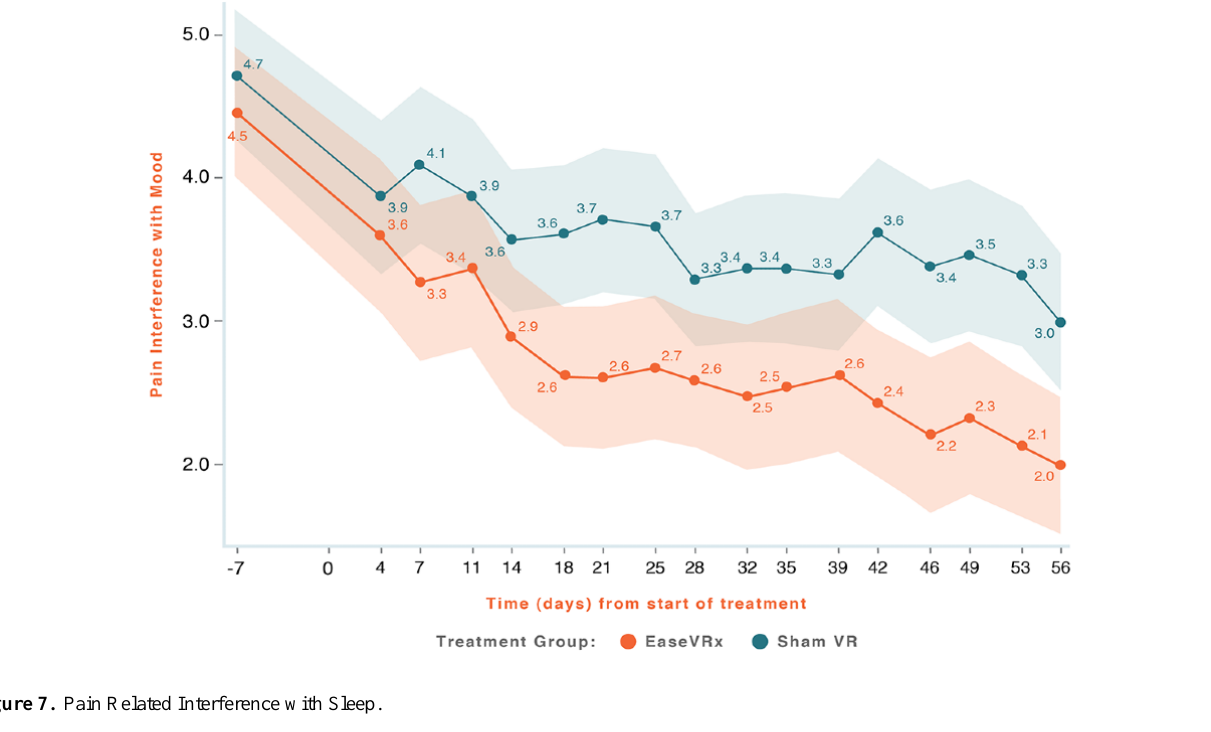
Figure 6. Pain-Related Interference with Mood.